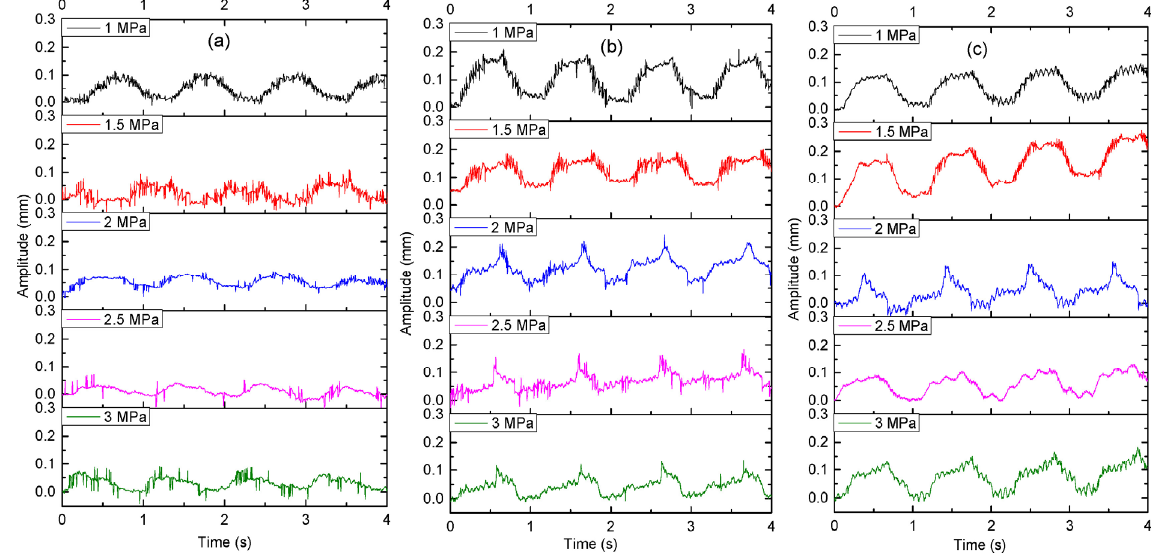
Fig. 11 Amplitude of the friction lining in the Y -direction: (a) K25 lining, (b) G30 lining, and (c) GM-3 lining.